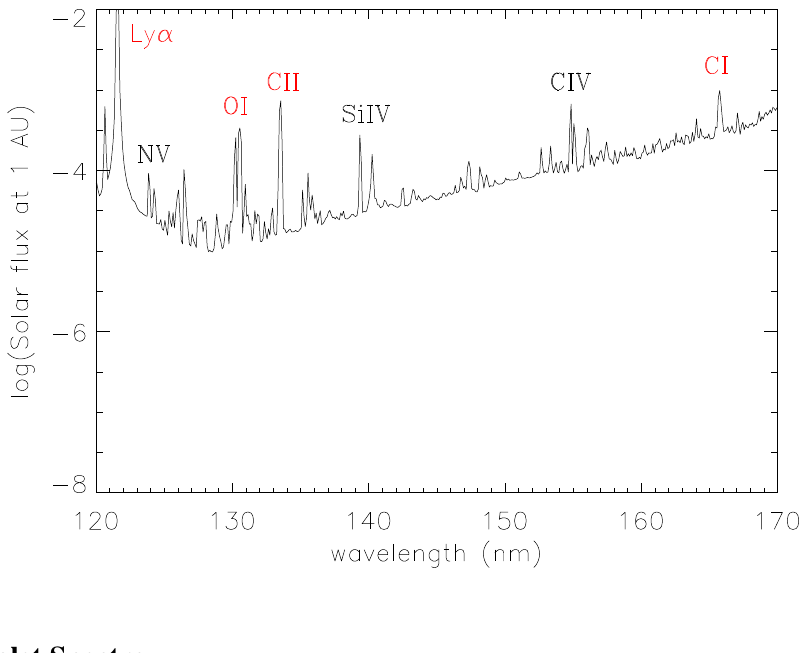
Figure 2. The Solar Irradiance Spectrum at solar minimum in the far ultraviolet (FUV) spectral range. Important emission lines are formed in the chromosphere (e.g., H I Lyman- α , O I, C I, and C II) and transition region (e.g., Si IV, C IV, and N V) are identified. The flux scale is the same as in Figure 1.